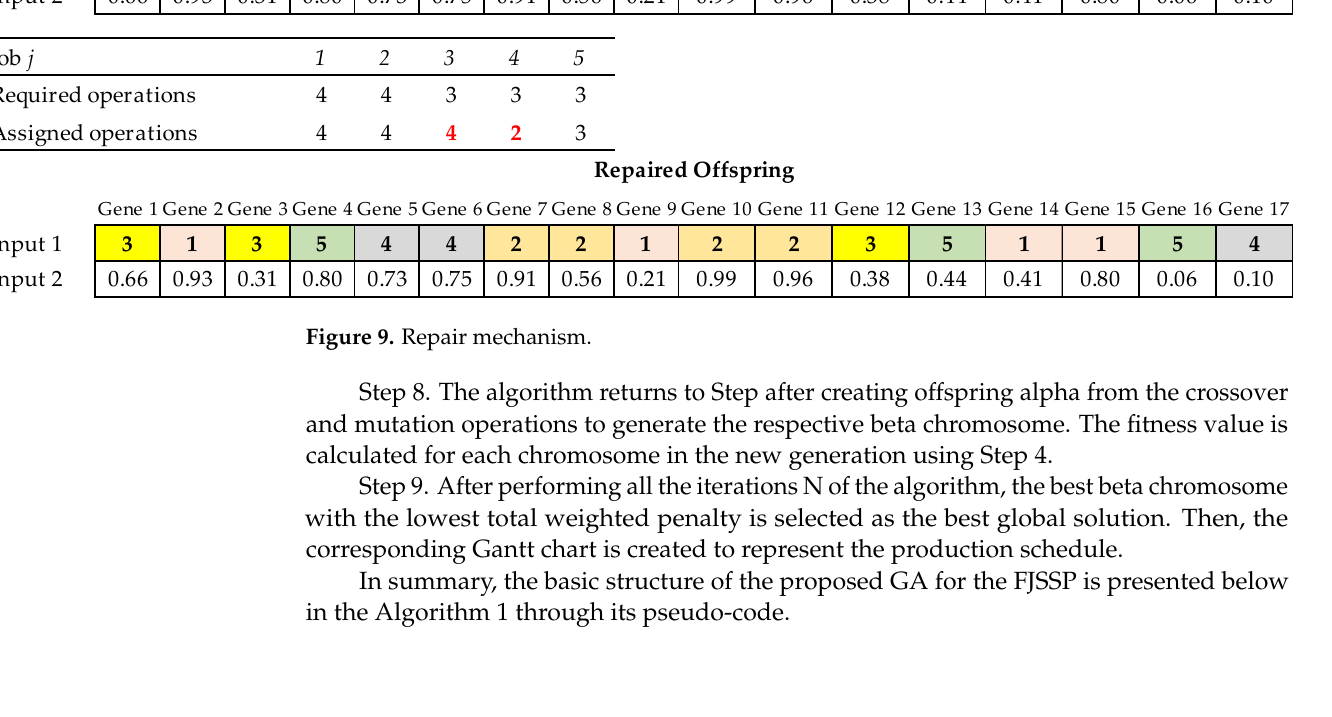
Algorithm 1 Genetic Algorithm for the FJSSP